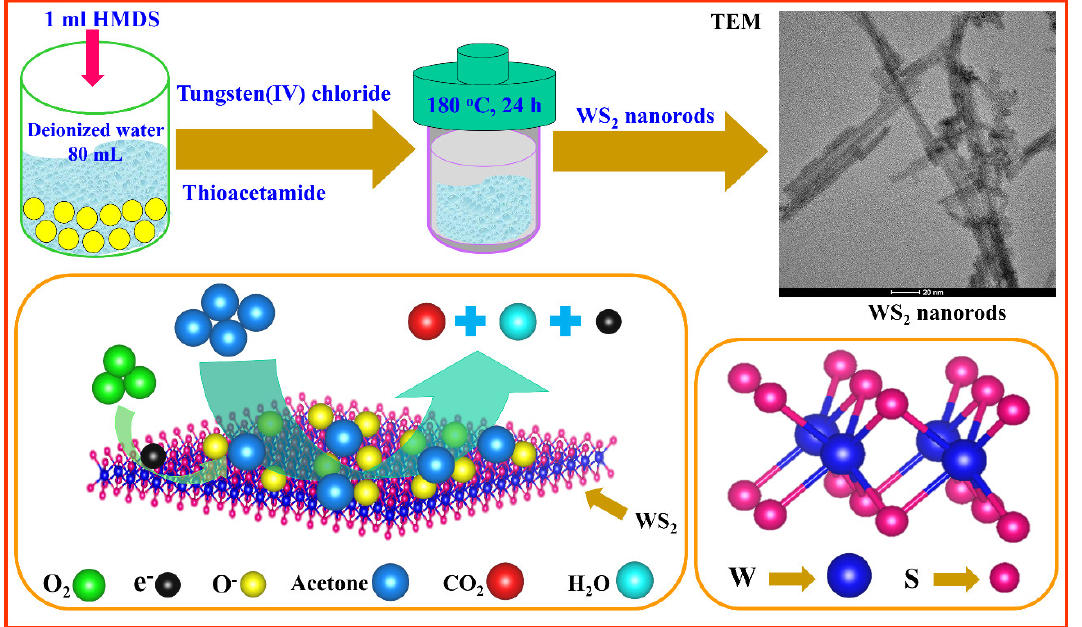
Figure 1. Concept of the WS 2 nanorod synthesis method. Crystallographic presentation of WS 2 crystal structure. Graphic of the acetone-sensing mechanism of the WS 2 sensor. Visualization and interactions of molecules and electrons during acetone sensing of WS 2 sensor.